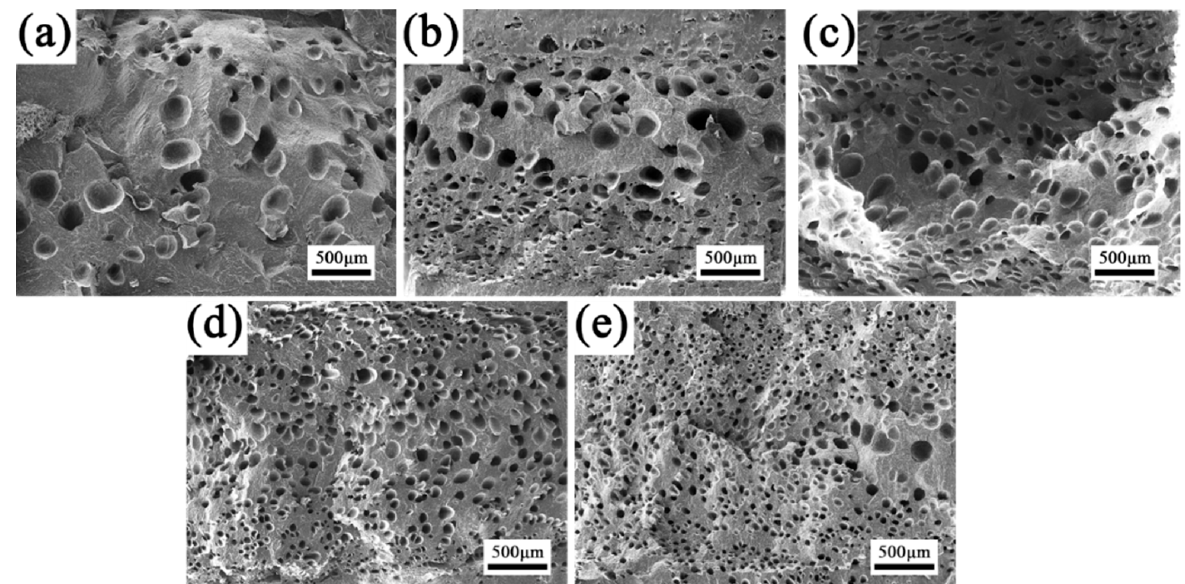
Figure 9. SEM images of the cellular structure in TD of foamed samples: ( a ) neat PP, ( b ) PP/PET(S), ( c ) PP/PET(S)/POE, ( d ) PP/PET(F), ( e ) PP/PET(F)/POE.